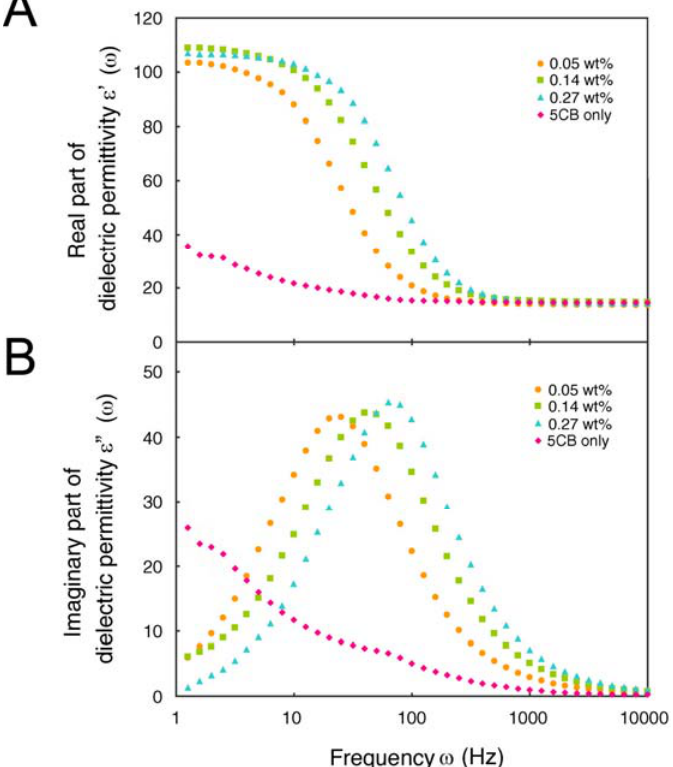
Figure 5. Dielectric relaxation dependent on the concentration of C10b. The dielectric permittivity of 5CB doped with various concentrations of C10b was analyzed; orange circles, green squares and blue triangles indicate the experimental data from 5CB doped with 200 μ M (0.05 wt%), 500 μ M (0.14 wt%) and 1000 μ M (0.27 wt%) C10b, respectively. The red rhombic dots indicate the data from pure 5CB as a reference. ( A ) shows the real part of the dielectric permittivity  ’ and ( B ) shows the imaginary part of the dielectric permittivity  ”. Adapted with permission from [53]. Copyright 2010 The Japan Society of Applied